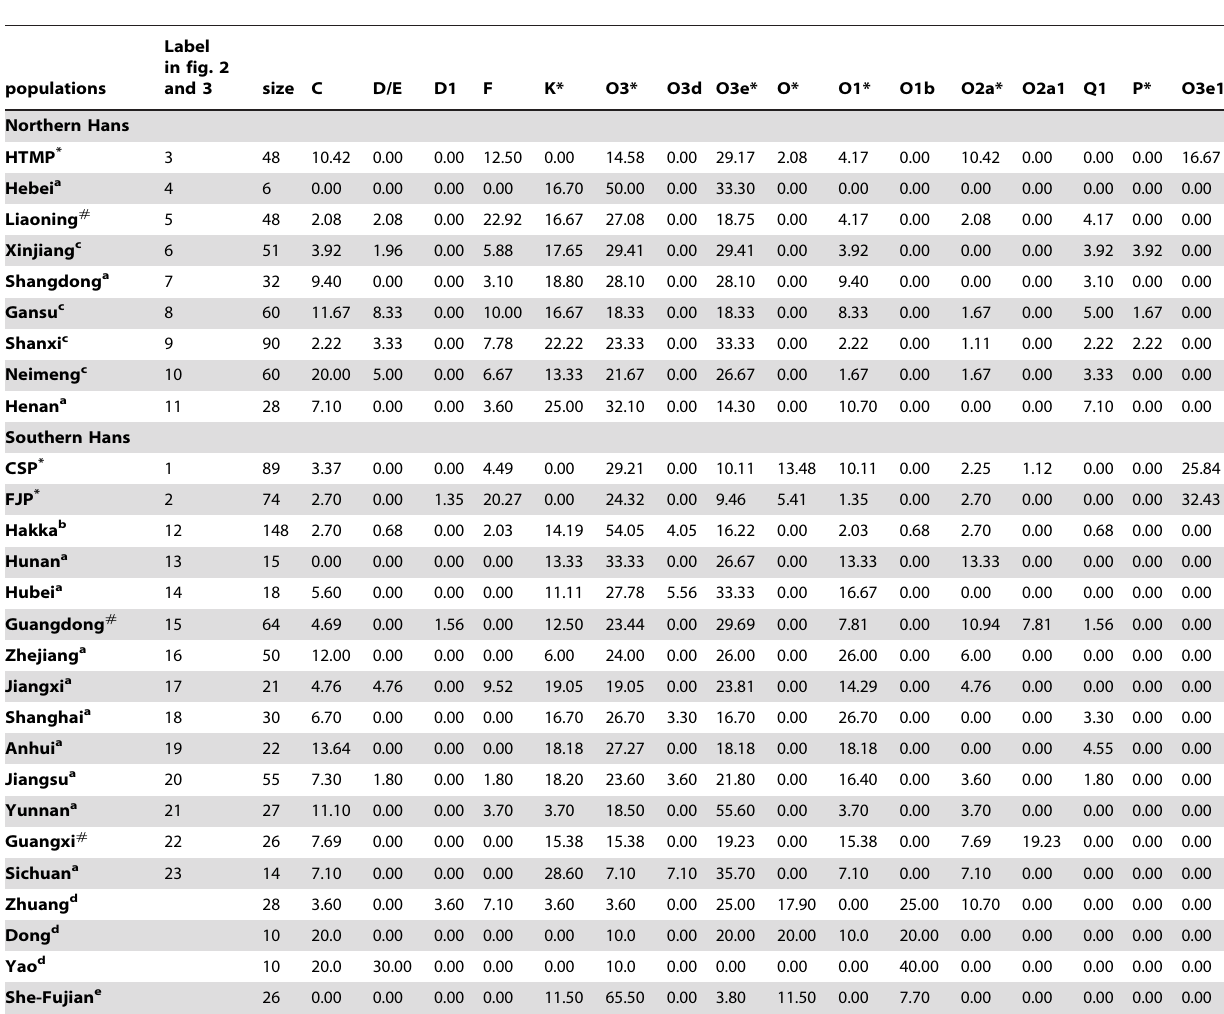
Table 5. Y-chromosome haplogroup frequency distribution in the 3 EC high-risk populations, 20 Chinese Hans and 4 minority nationalities.